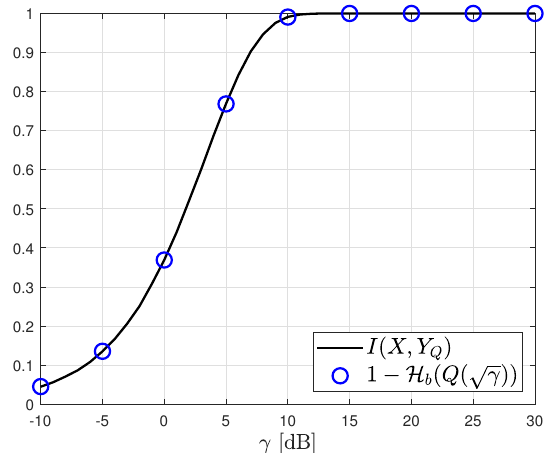
Figure 3. Verification for the capacity